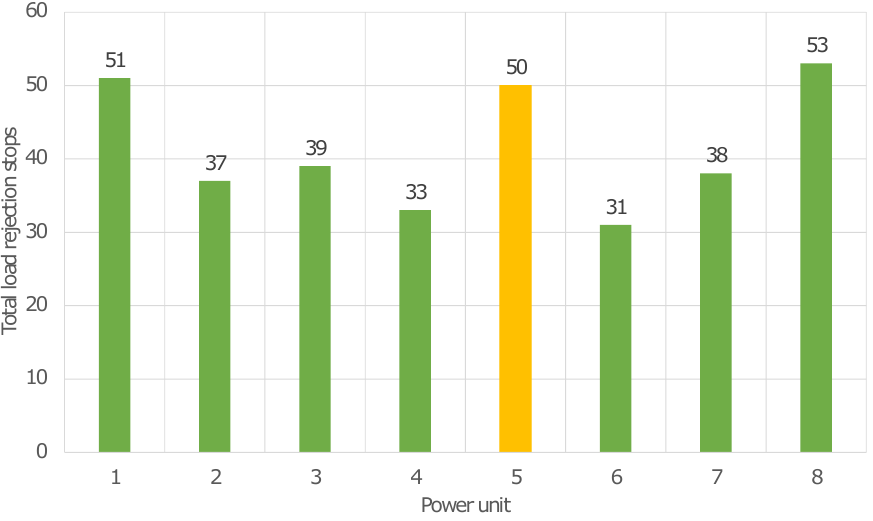
Figure 5. Historical forced exits with load rejection for the 1997–2019 period.